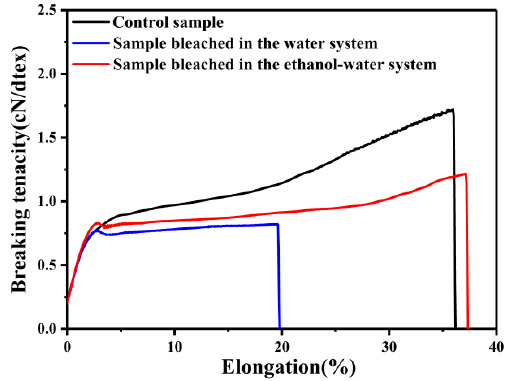
Figure 4. Tenacity-elongation curves of camel hair before and after bleaching treatment.